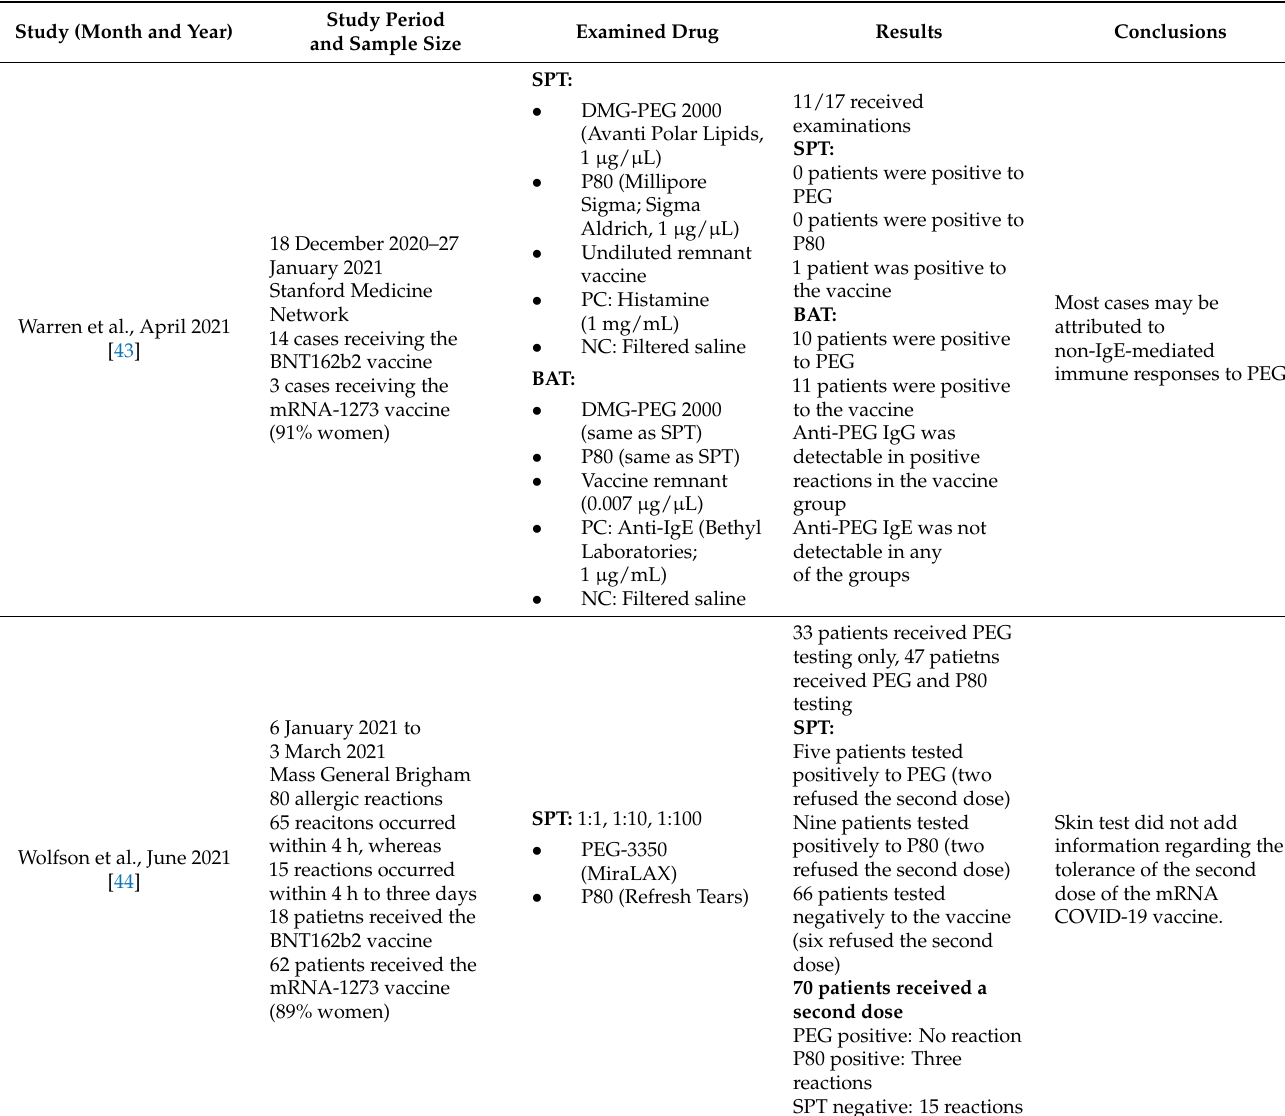
Table 1. Acute hypersensitivity reactions following the first dose of coronavirus disease 2019 (COVID-19) vaccination, as well as results of skin prick tests, intradermal tests, and/or basophil activation